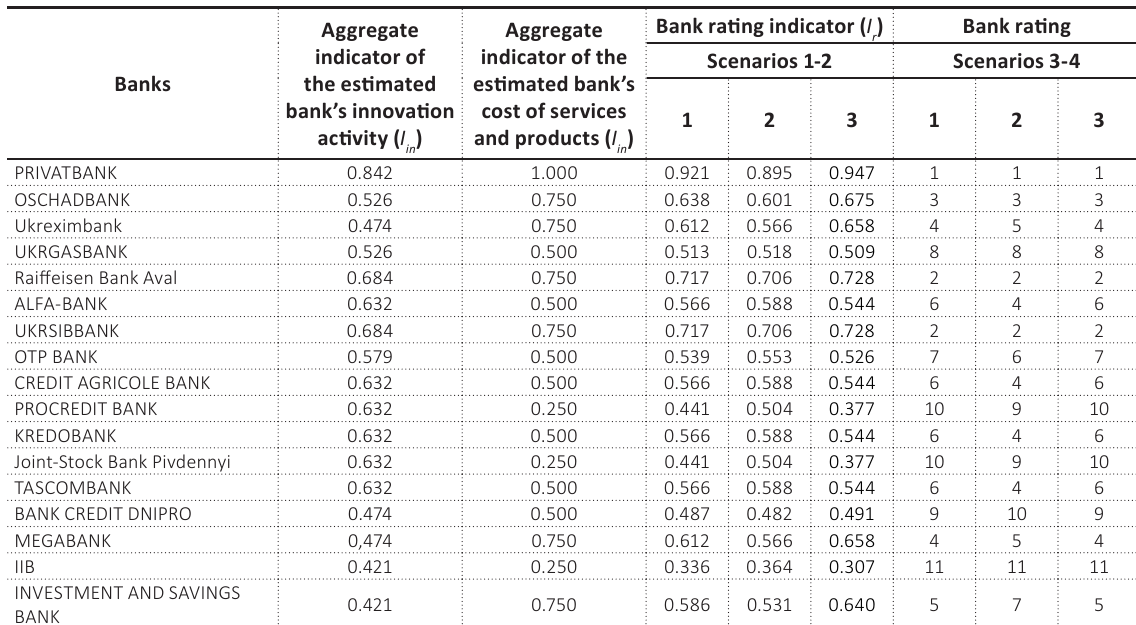
Source: Own processing.